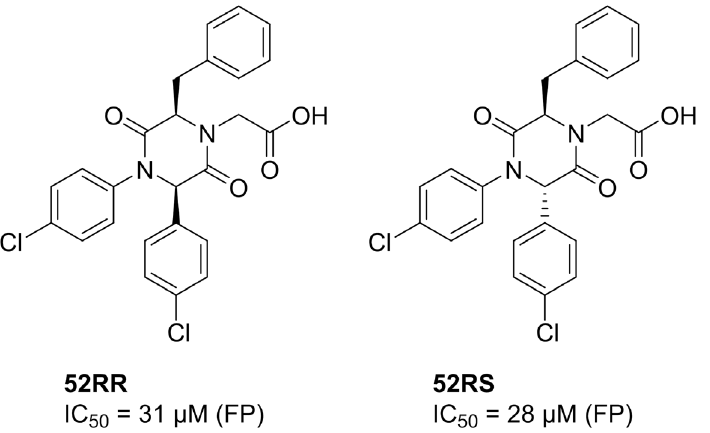
Fig 20. 2,5-DKPs as inhibitors of the MDM2-p53